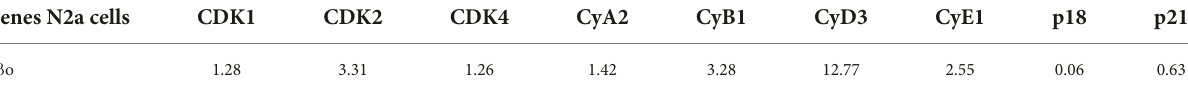
TABLE 4 The expression of cell cycle-associated genes in A β o-treated N2a cells. Genes N2a